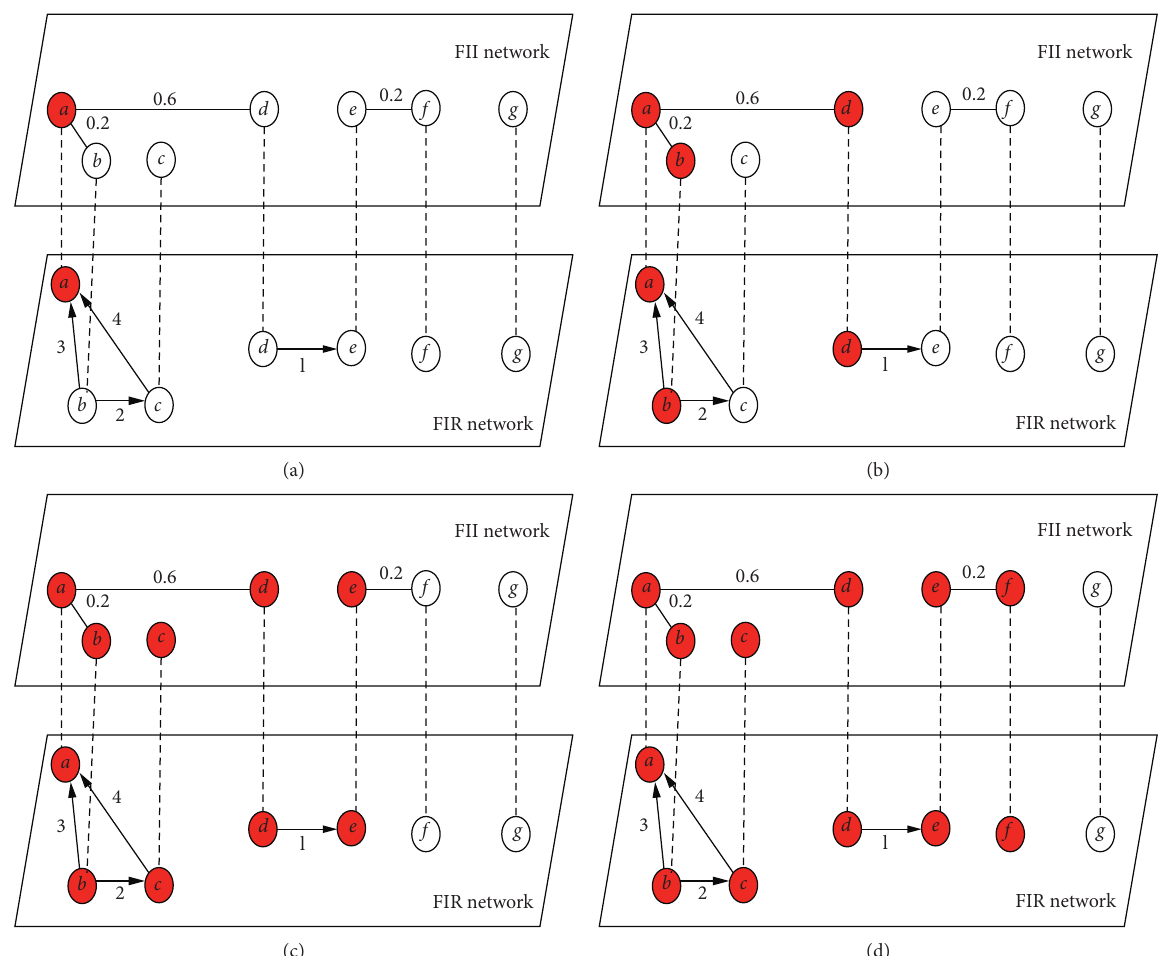
Figure 8: Probability 1 information-spreading history in a 7-node network: (a) t � 1, (b) t � 2, (c) t � 3, and (d) t � 4.